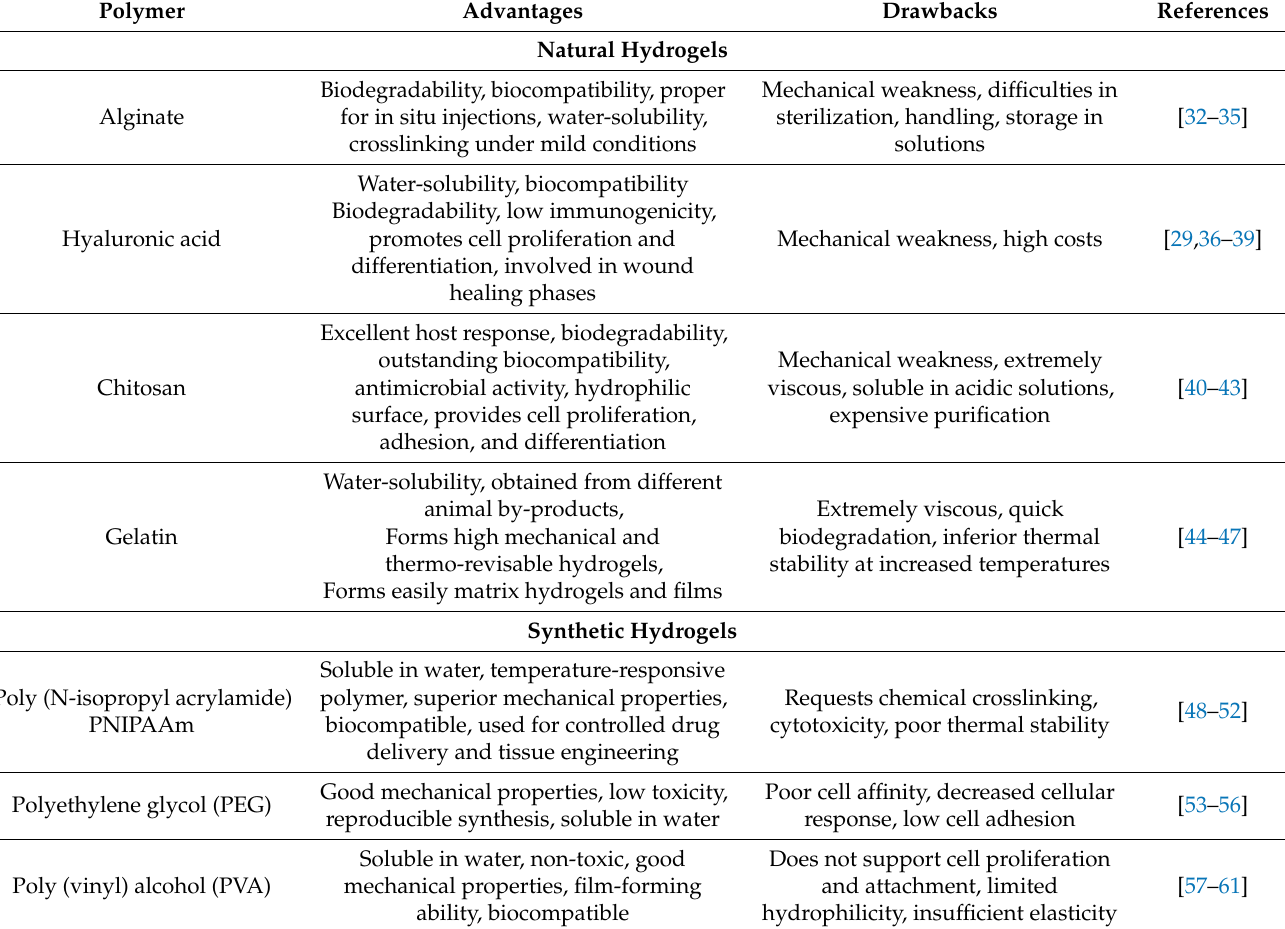
Table 1. The main advantages and disadvantages of natural and synthetic